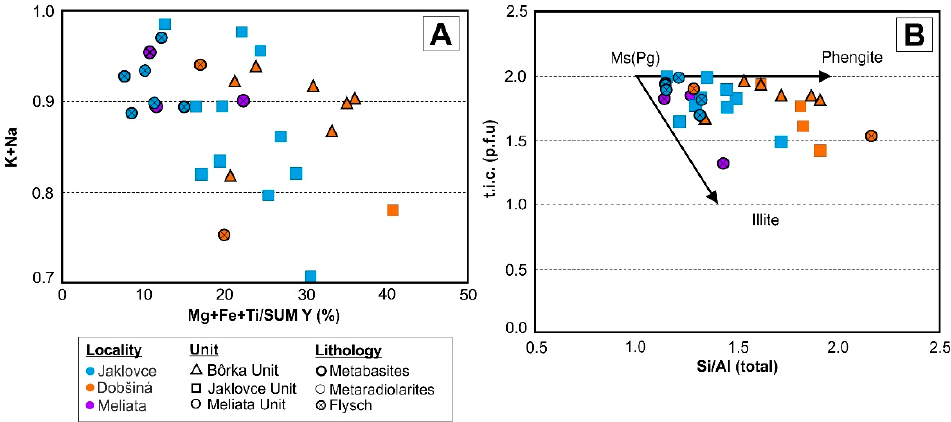
Figure 22. ( A ) K + Na vs. Mg + Fe + Ti / SUM Y (%) compositional trend of white mica from Jaklovce and Meliata units metasediments and Bretka Unit metabasites: ( B ) Ms–Ill–Ph alteration diagram after [54] (Table 4); compositional parameter t.i.c. = total interlayer charge of K + Na + 2Ca (in a.p.f.u. ) as in [114].